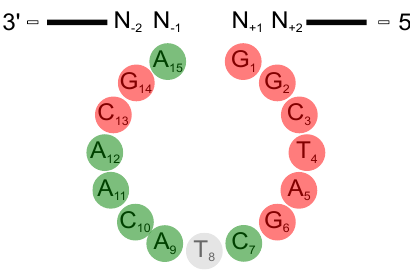
Figure 4. Schematic representation of the 10-23 DNAzyme with emphasis on the deoxynucleotides within the catalytic loop. Modification of the deoxynucleotides 1–6, 13, and 14 (red circles) greatly affect the cleavage rate, whereas exchanges of deoxynucleotides 7–12 and 15 (green circles) only slightly affect the DNAzyme activity. Deletion of the deoxynucleotide dT 8 leads to an active 10-23 DNAzyme (grey